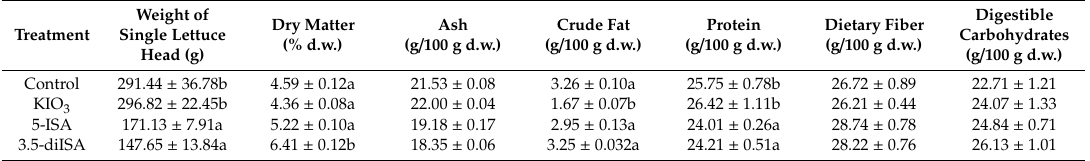
Table 1. Weight of lettuce head, dry matter content, and the chemical composition (means for 2018–2019). Weight of Dry Matter Ash Crude Fat Treatment Single Lettuce (% d.w.) (g / 100 g d.w.) (g / 100 g Head (g)